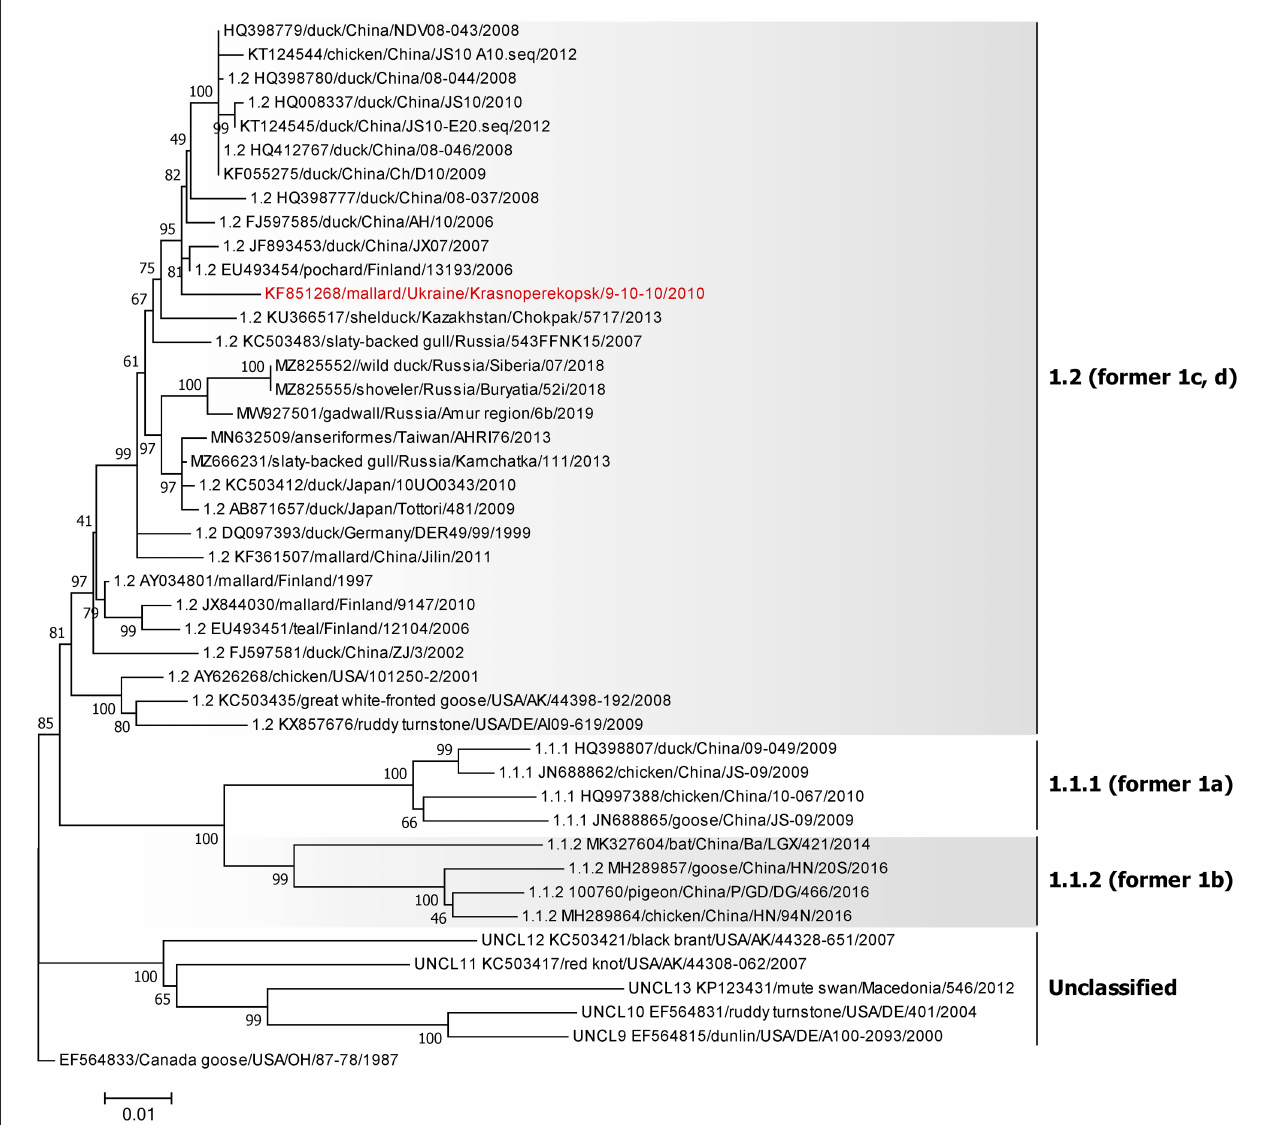
FIGURE3 Phylogenetic analysis of NDV class I isolates based on the complete fusion gene sequences constructed with the maximum likelihood method with 1,000 bootstrap replicates. The analysis involved 44 nucleotide sequences. The tree was rooted to the oldest class I NDV isolate EF564833/Canada goose/USA/OH/78/1987. All positions containing gaps and missing data were eliminated. There were a total of 1,662 positions in the final data set. The isolates used in this study are shown in red. The Roman numerals on the right of the phylogenetic tree represent the respective sub-genotype for each isolate in accordance with the current classification (5) and the former nomenclature (58) is listed in parenthesis for